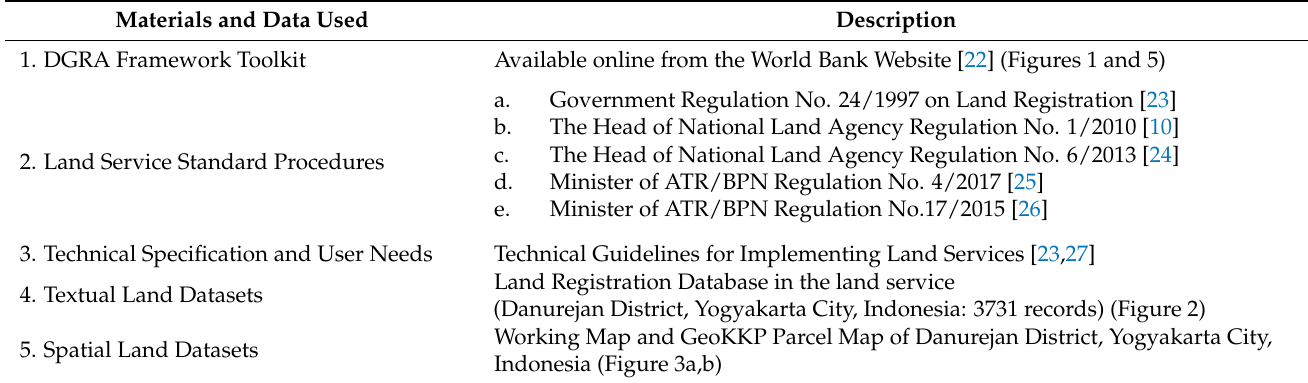
Table 1. The materials and data